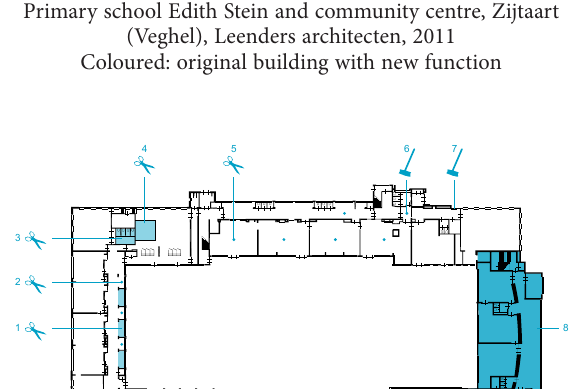
Figure 2.8. Adaptive reuse